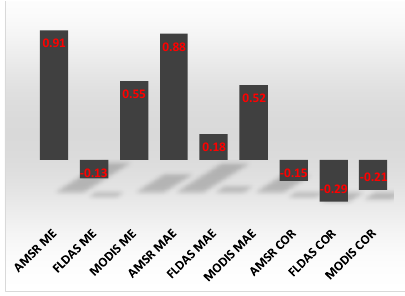
Figure 11. Bar graph of the correlations between elevation and accuracy statistics for the various satellite/interpolated data products.